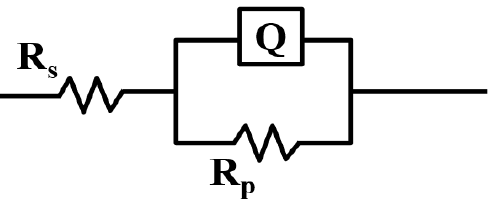
Figure 8. Impedance test EIS equivalent circuit diagram (R S : solution resistance; R p : sample re- sistance).